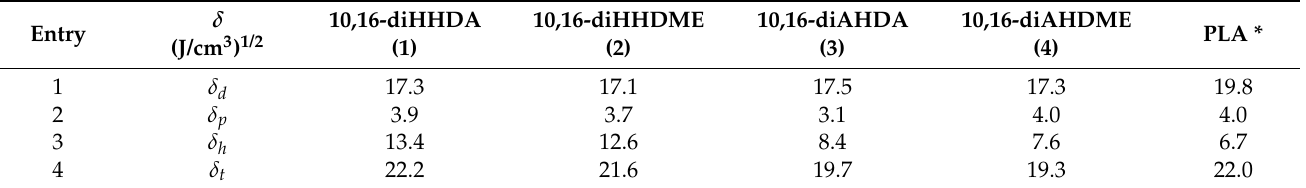
Table 2. Hansen solubility parameters, δ t and their dispersive, δ d polar, δ p and hydrogen bonding group δ h contributions for derivatives 1 – 4 and